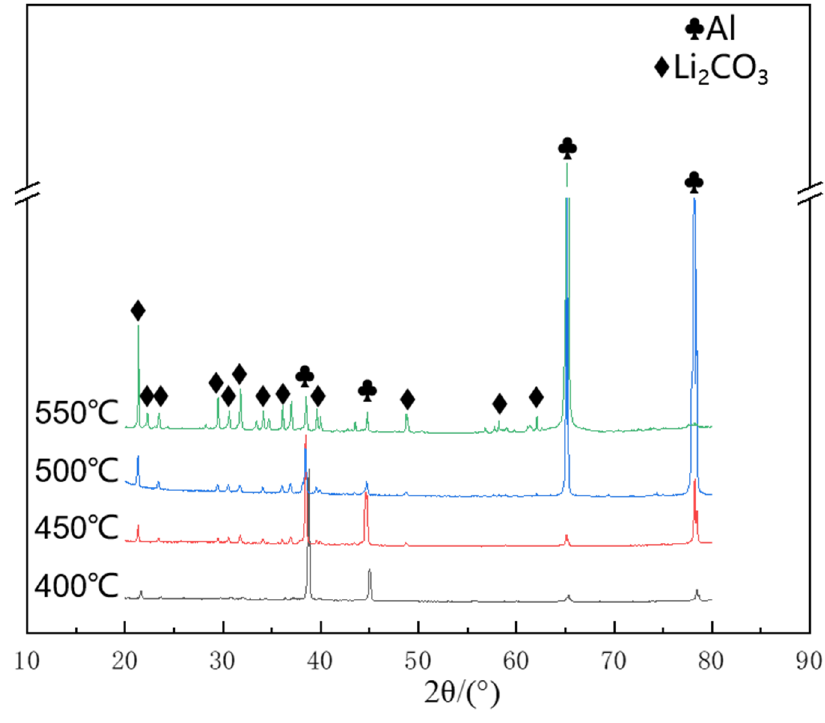
Figure 10. XRD pattern of Al-2Li-0.2Sc alloy oxidized at different temperature for 5 h. The XRD phase analysis results of the Al-2Li-0.2Sc alloy with a Sc element show that the Li 2 CO 3 peak formed by oxidation at 400 ◦ C and 450 ◦ C is relatively weak, while the Li 2 CO 3 peak formed by oxidation at 500 ◦ C and 550 ◦ C is gradually enhanced—that is, the Li 2 CO 3 produced increases. However, no Sc-containing phase was detected in the